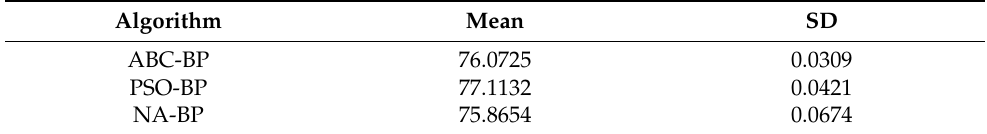
Table 3. Comparison with other methods.